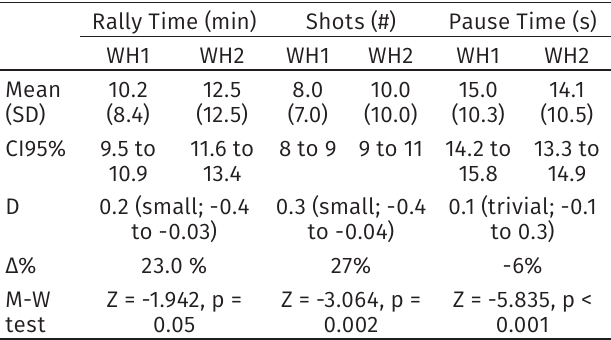
Table 1. Descriptive results and comparison between WH1 vs WH2